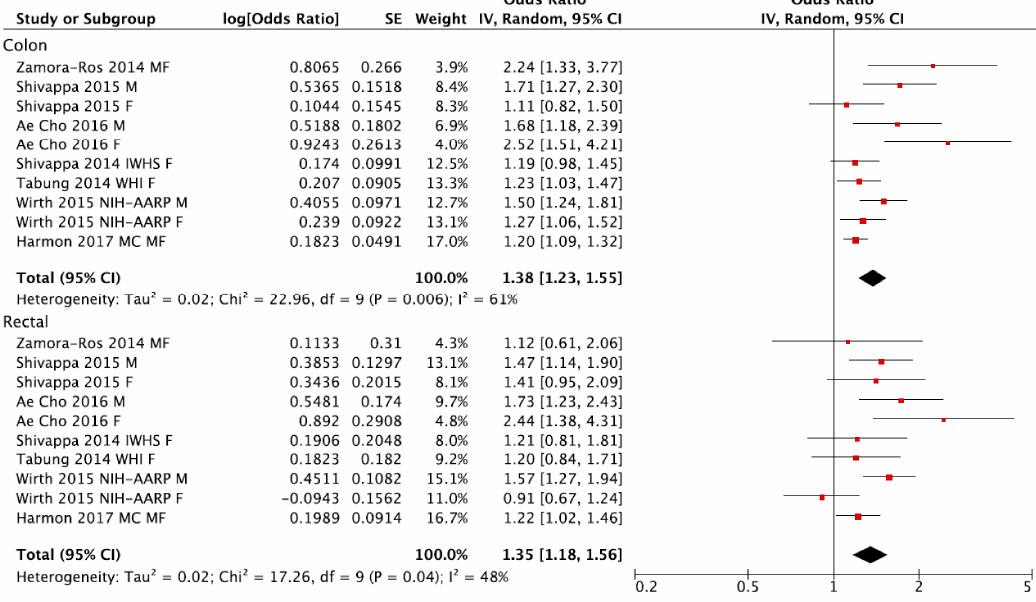
Figure 6. Forest plot of summary relative risks (RRs) of colon and rectal cancer for the highest versus lowest (reference) category of Dietary Inflammatory Index (DII).